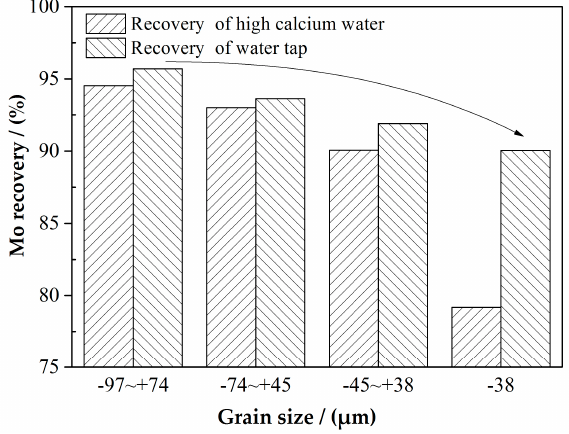
Figure 3. Molybdenite recovery in AM flotation from different size fractions in the absence and presence of 800 mg/L Ca 2+ at pH 8.